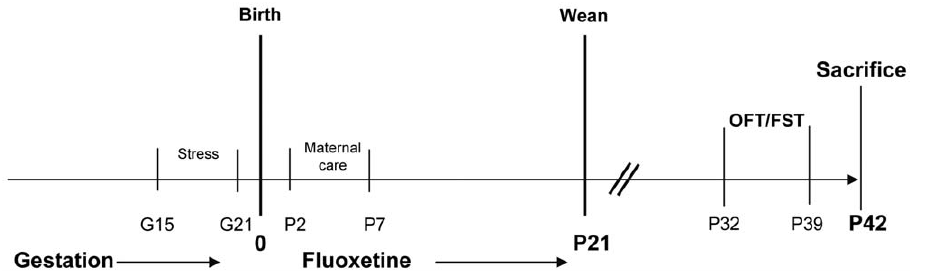
Figure 1. Timeline of experiment. Stress was administered between GD15-21. Fluoxetine treatment to the mother began 1 day after birth and continued until weaning (P21). Between P32 and P39, offspring were subjected to behavioral tasks. At P42, offspring were